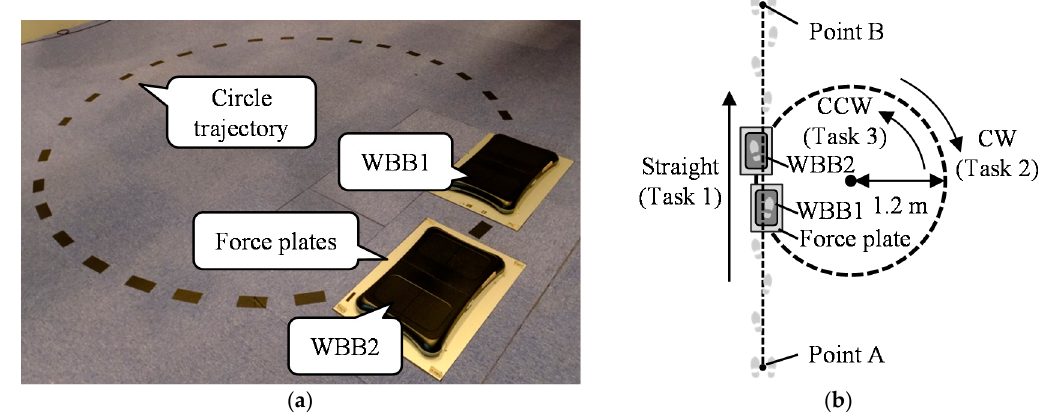
Figure 2. Experimental walkway including two Nintendo Wii Balance Boards (WBBs) and force plates. ( a ) Actual setup; ( b ) schematic walkway and walking directions of each task. ( a ) Actual setup; ( b ) schematic walkway and walking directions of each